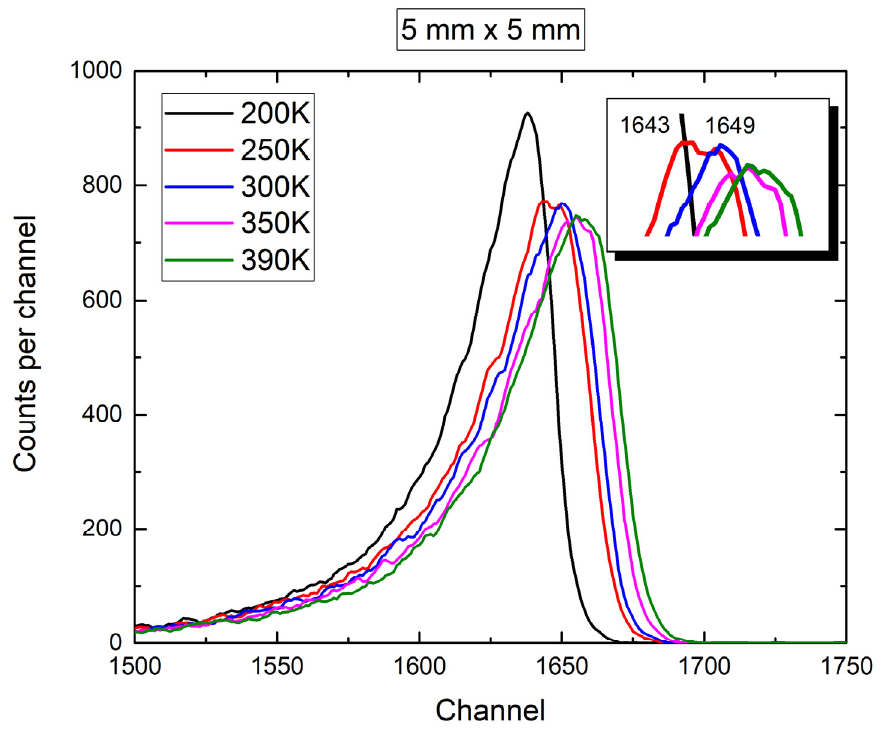
Figure 6. Response of 4H-SiC detector with active surface area of 5 mm × 5 mm to Am-241 alpha particles in a vacuum at different temperatures.